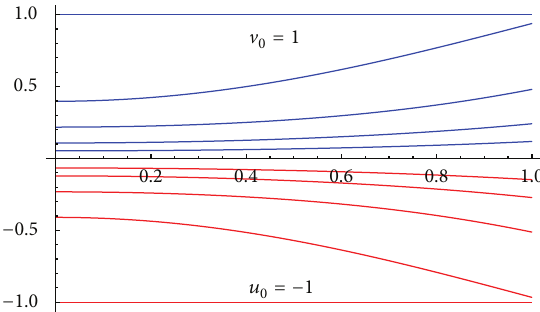
Figure 8: Plot of 𝑢 𝑛 (blue) and V 𝑛 (red), 𝑛 = 0, 1,2, . .. ,20 for 𝜆 = −20